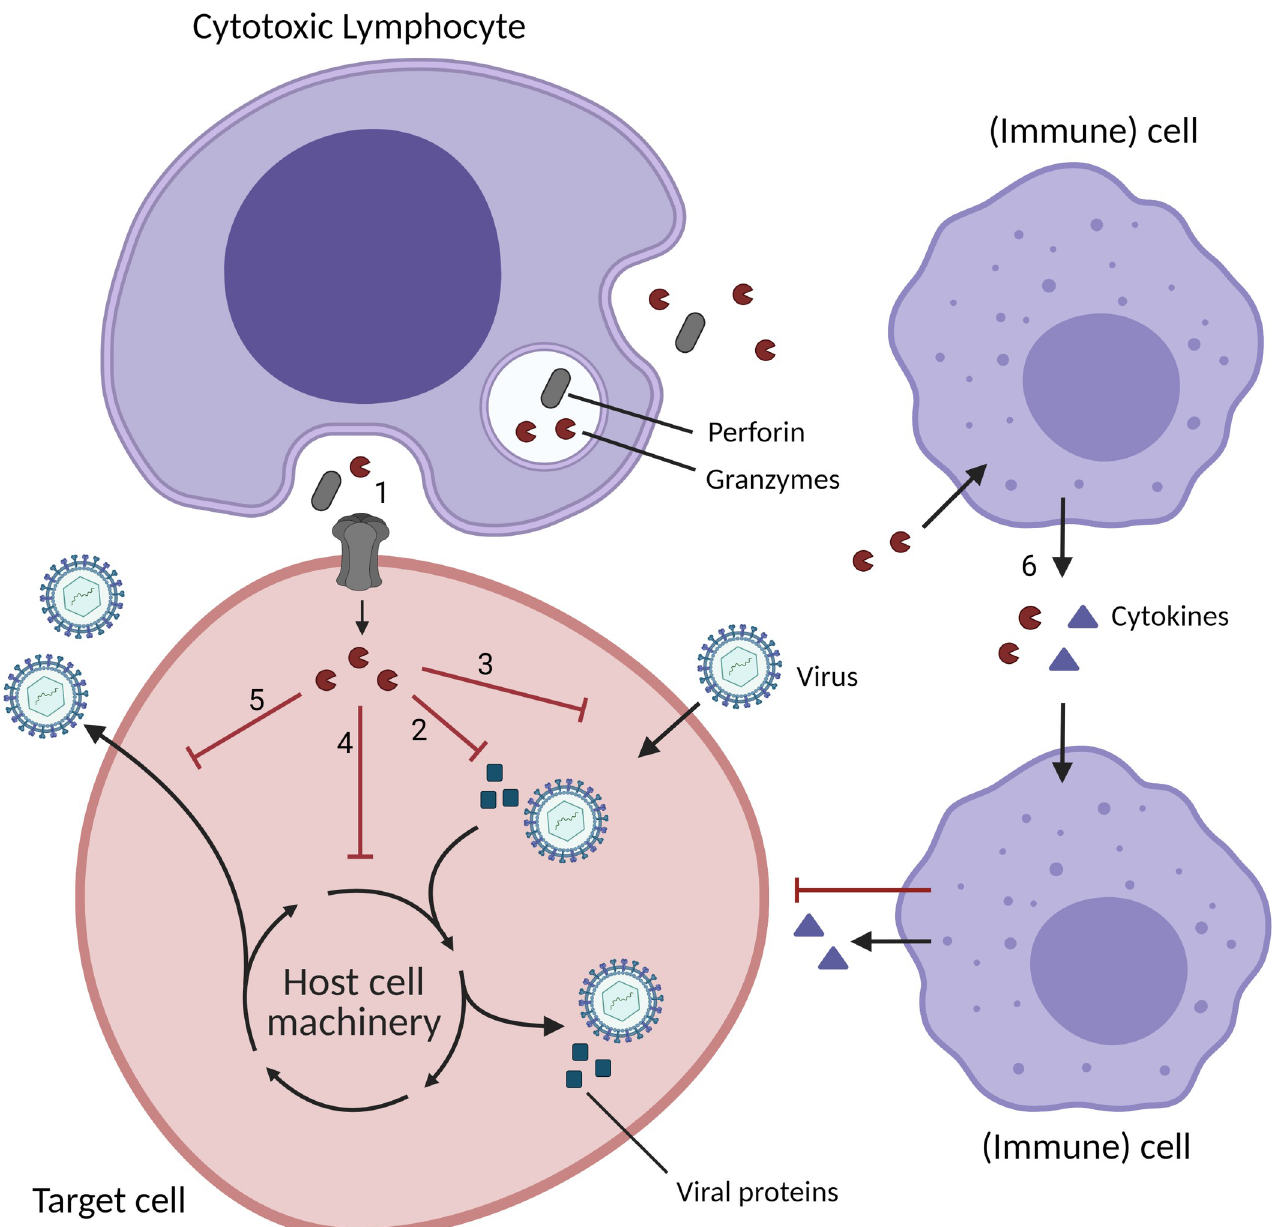
Fig 1. Schematic overview of the noncytotoxic functions of Gzms in viral infection. CLs secrete perforin and Gzms into the immunological synapse. Perforin pores mediate Gzm entry in the target cell (1). Gzms cleave and (in)activate viral proteins (2) and host cell proteins inside the cytoplasm and the nucleus necessary for viral entry (3), replication, protein synthesis, virion assembly (4), and viral release (5). CLs and also other cell types (e.g., macrophages) can directly secrete Gzms in the microenvironment. These extracellular Gzms can induce pro-inflammatory cytokine release by multiple cell types, such as monocytes, macrophages, DCs, mast cells, fibroblasts, and epithelial cells, further supporting the antiviral immune response (6). Created with BioRender.com. CL, cytotoxic lymphocyte; DC, dendritic cell; Gzm,